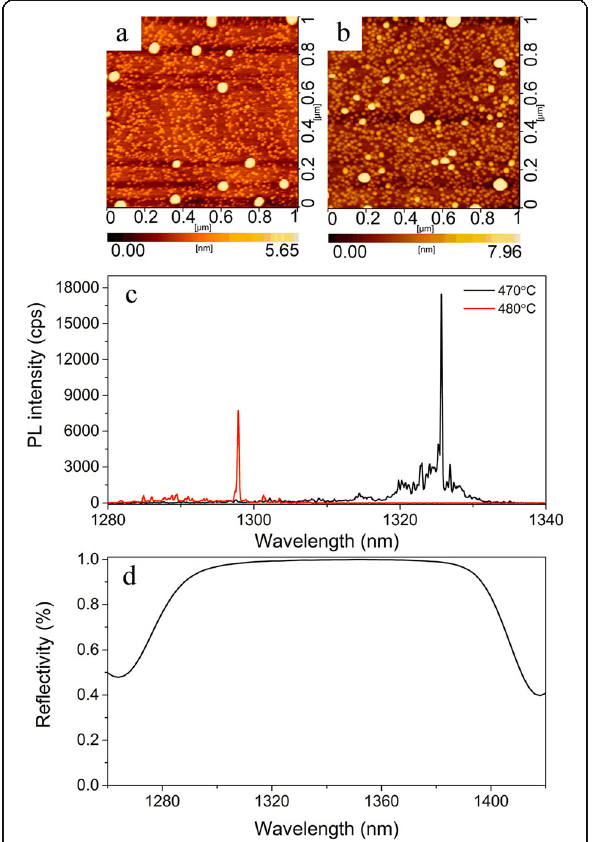
Fig. 1 1 × 1 μ m 2 atomic force microscopy (AFM) image of uncapped BQDs grown at a 480 and b 470 °C. c μ PL spectra of BQDs embedded in DBR cavities, grown at 480 °C ( red ) and 470 °C ( black ), measured at 4 K. d Reflectivity spectrum of the bottom DBR, measured at room